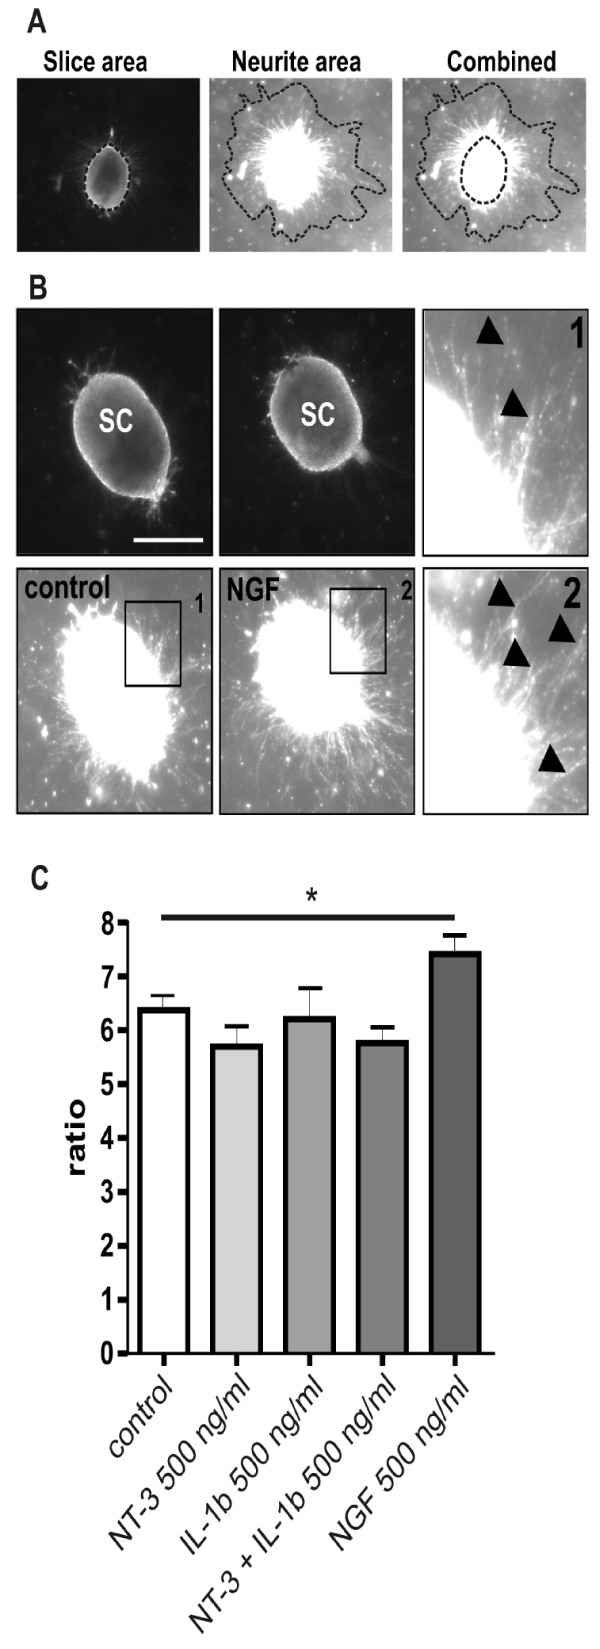
NT-3 and IL-1beta do not increase neurite outgrowth of transverse spinal cord slices. A: Transverse spinal cord slices were prepared from E13 spinal cords and the ratio between neurite area and slice area were compared. B: representative photomicrograph showing the increase in outgrowth of NGF treated EC compared to control. NGF (500 ng/ml) serves as positive control. C: NT-3 and IL-1β (500 ng/ml) were added to the culture medium of organotypic transverse spinal cord slices. Only NGF significantly increases neurite density, while NT-3, IL-1β or a combination of these factors does not influence neurite outgrowth. n = 9-11 slices. *: Statistically significant difference to control; p < 0.05 (Mann Whitney U test). Arrow heads indicate outgrowing neuritis. Scale bar: 50 μm.